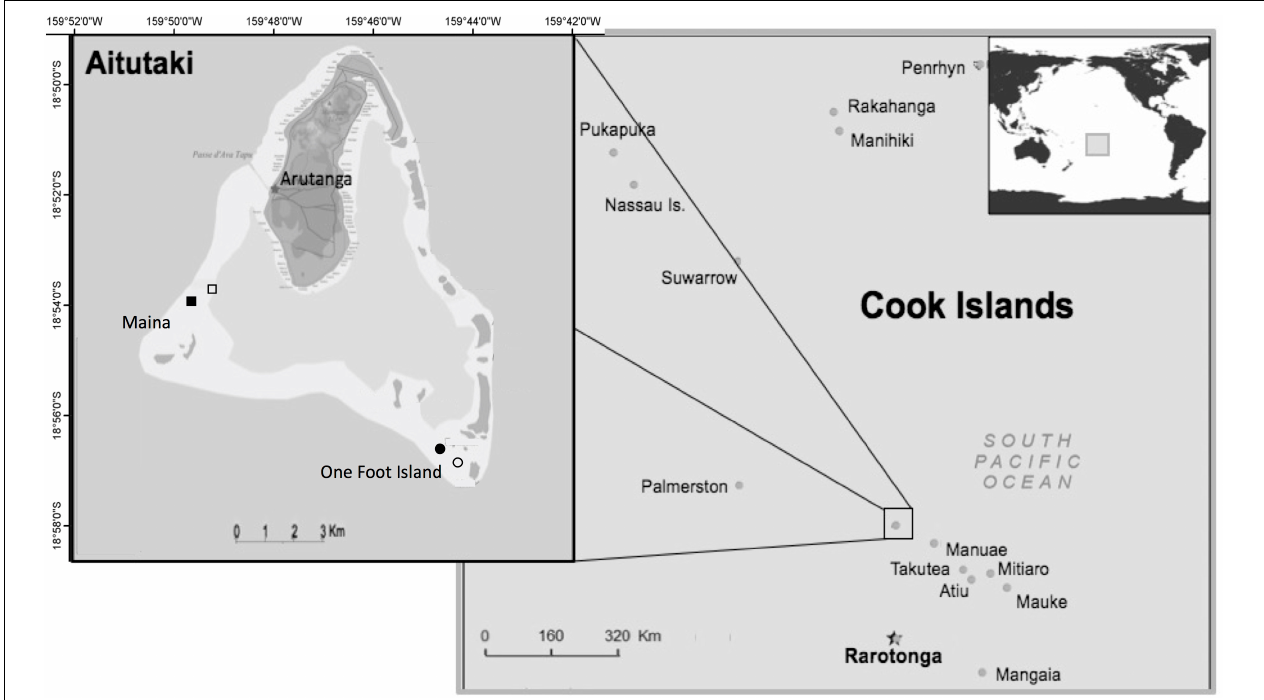
FIGURE 1 | Location of Aitutaki in the southern group of the Cook Islands (right) in the South Pacific Ocean. Map of Aitutaki near-atoll with its shallow lagoon (left) . Tourism feeding sites (filled symbols) and experimental feeding sites (open symbols) are indicated in One Foot (southeast) and Maina (southwest). Images adapted from Nevers (2008), creative